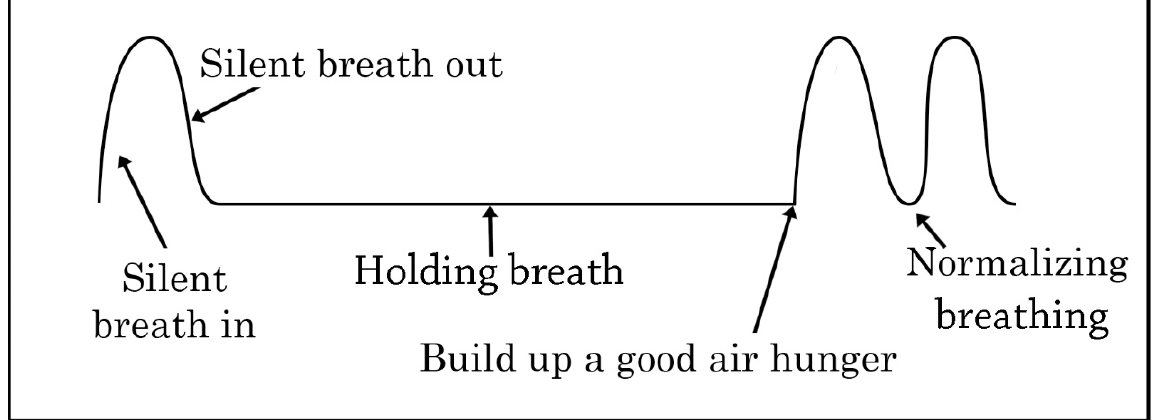
Figure 2. Breathing re-education. A video demonstration of decongesting nose exercise is available as supplementary material (Video S1).